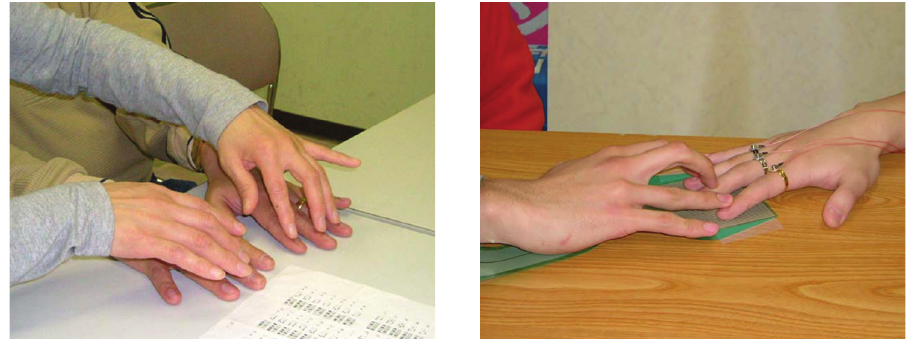
Figure 1: Two-handed Finger Braille and one-handed Finger Braille.